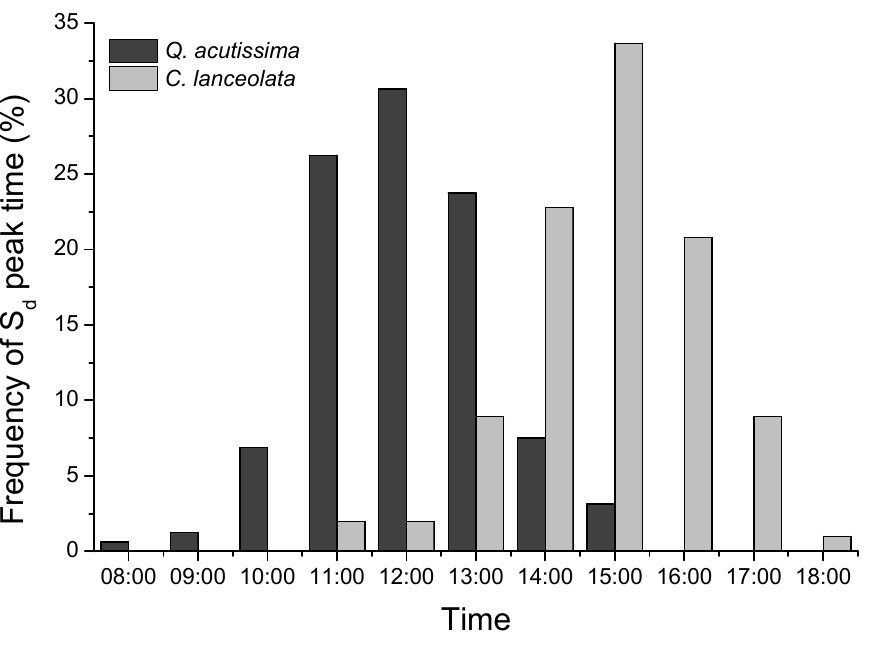
Figure 6. The frequency of time of maximum sap flow density. Data were from the entire sampling period on days with no rainfall.